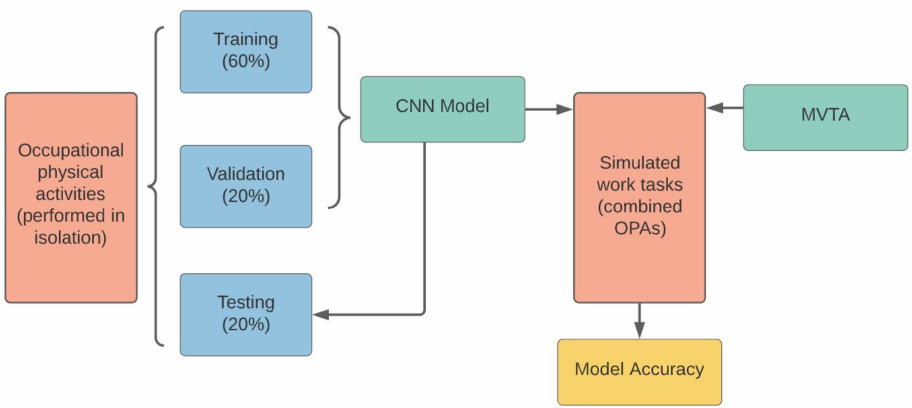
Figure 5. This diagram shows the approach for assessing the accuracy of the CNN model. Data collected from the OPAs performed in isolation were divided into 60%, 20% and 20% for training, validation, and testing, respectively. The trained model was applied to testing data from the OPAs performed in isolations, then the simulated work tasks to predict OPAs. Multimedia video task analysis was performed on the simulated work tasks and compared with model predictions to estimate the accuracy of the predictive model.